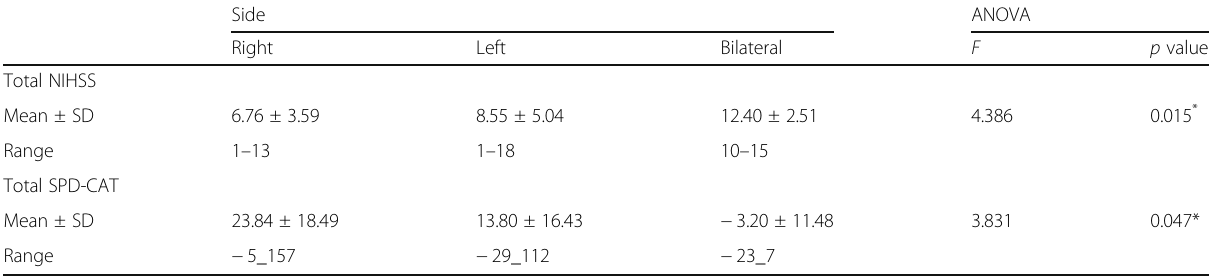
Table 8 Correlation between total NIHSS, SPD-CAT, and lesion side Side